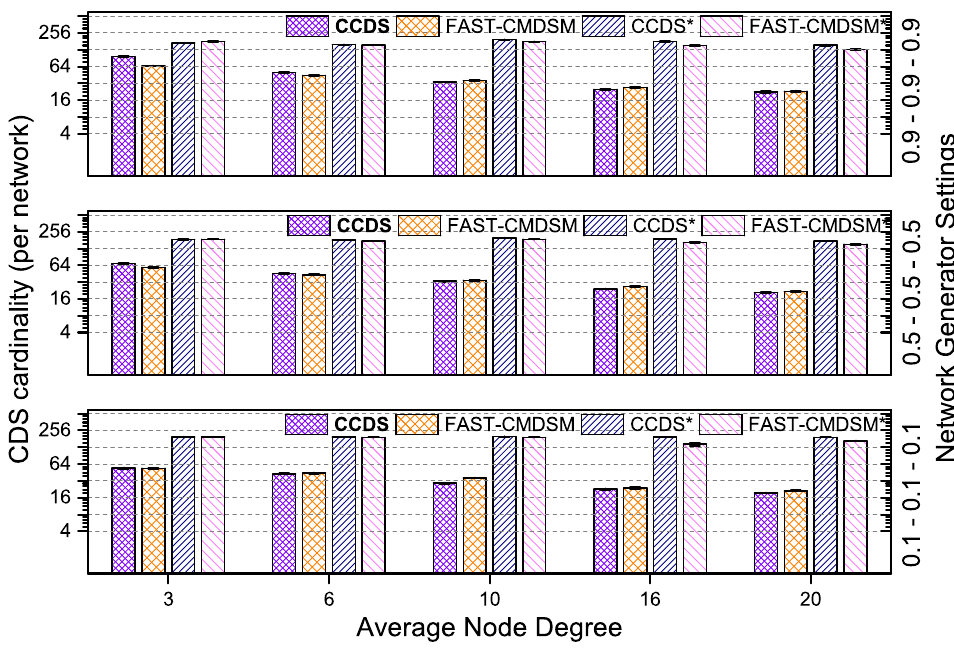
Figure 5. Impact of topology density (CDS size aggregated over all